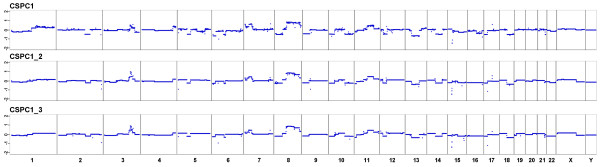
Analyses of serial plasma samples from patient CSPC1. The first plasma sample (CSPC1) was collected 12 months after initial diagnosis, only a biopsy had been taken from the primary tumor to confirm diagnosis. The interval between the first and second (CSPC1_2) sample was 5 months and 1 month between the second and third (CSPC1_3). The patient was clinically responding to castration therapy.